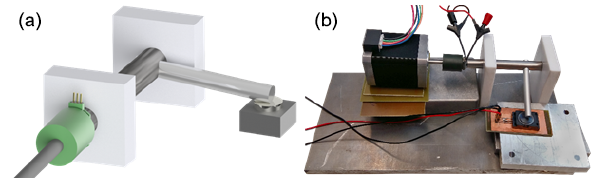
Figure 7. Optimized measurement setup: (a) schematic depiction showing the steel tube, PTFE bearings, engine axis, nut and screw, lever and force sensor; (b) photography including the engine and connecting wires.